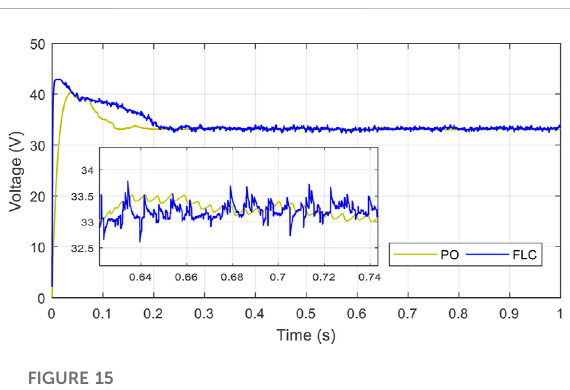
FIGURE 15 Experimental voltages for both FLC and P&O controls.